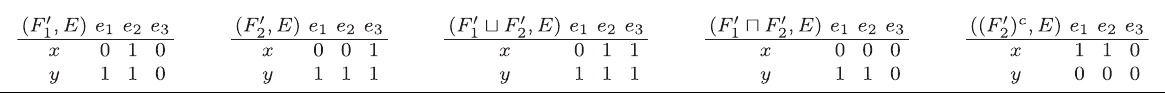
Soft union, intersection, and complement: their tabular representation for the soft sets defined in Example